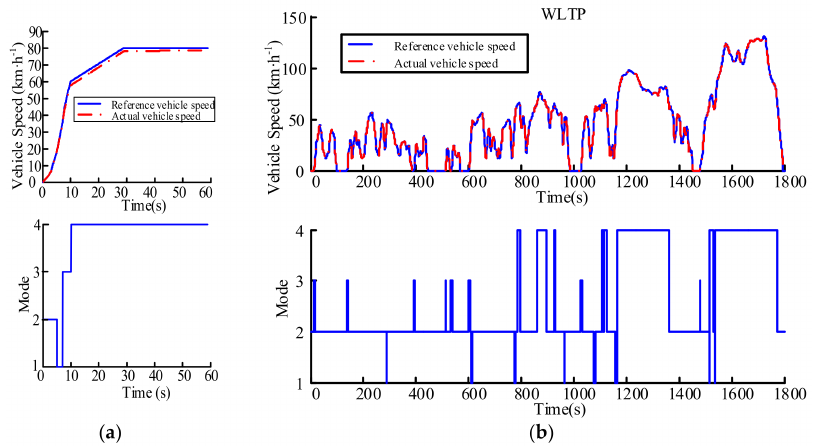
Figure 7. Simulation results for mode division under ( a ) rapid acceleration; ( b ) Worldwide Harmonised Light Vehicle Test Procedure (WLTP) drive